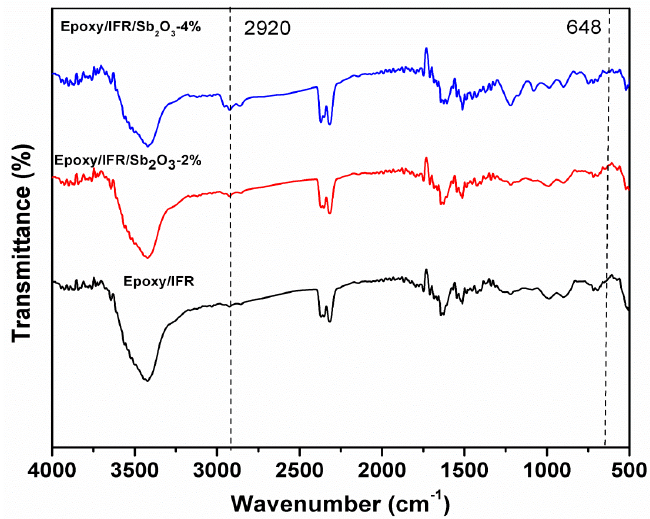
/ IFR, Epoxy / IFR / Sb